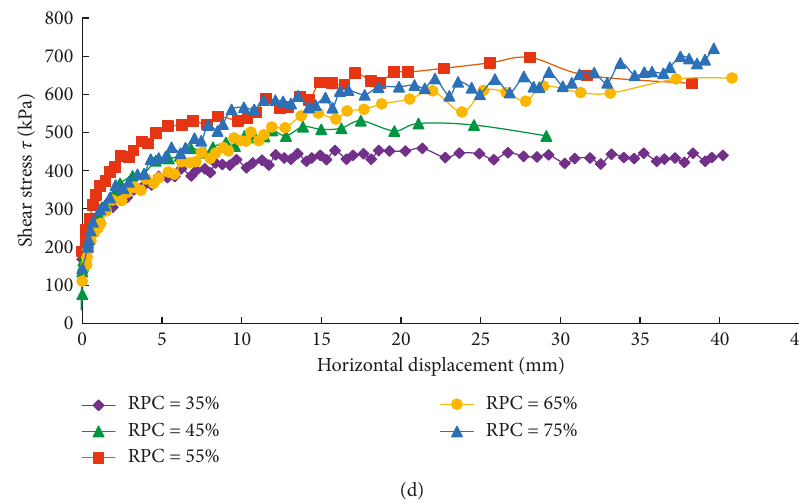
Figure 6: Shear stress and horizontal displacement curves of different rock particle content samples under the same normal stresses: (a) σ � 141.5kPa; (b) σ � 283.1 kPa; (c) σ � 424.6kPa; (d) σ �